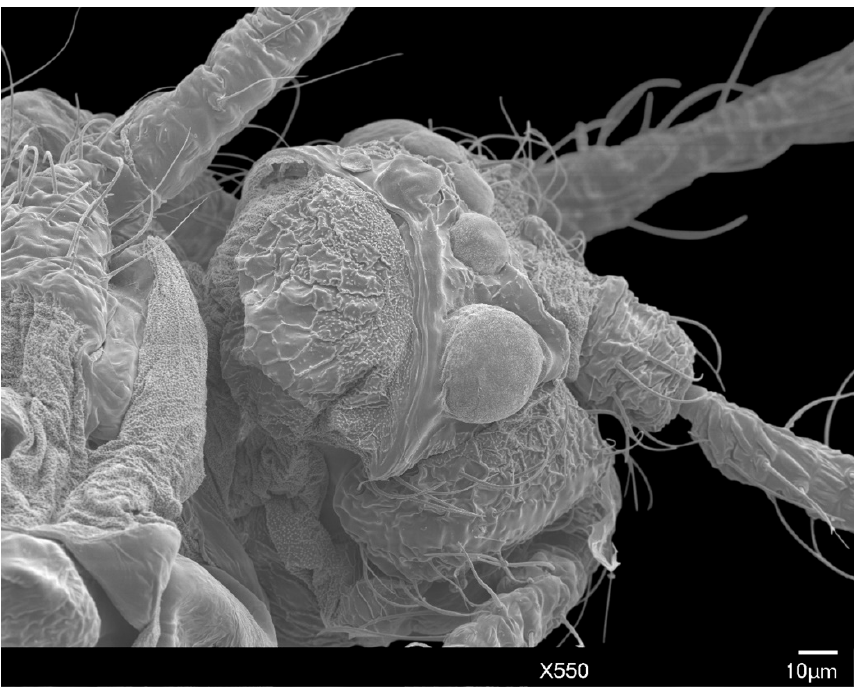
Figure 5. SEM lateral view of the male A. galliformis head showing the ventral simple eyes, ocellus, pedicel, and genae.